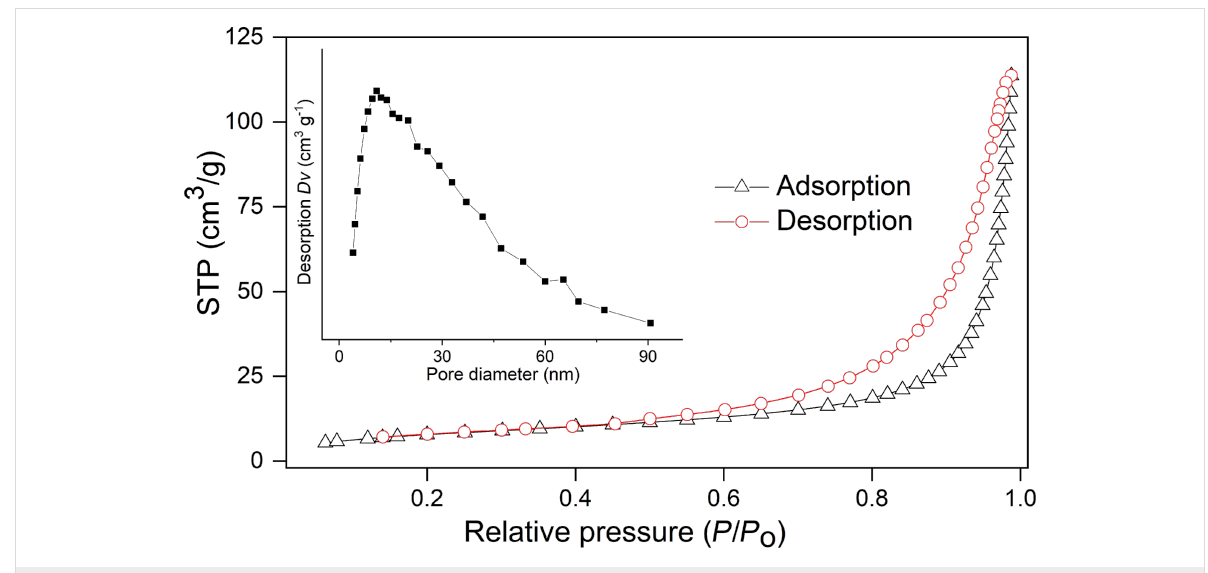
Figure 3: Nitrogen adsorption and desorption isotherms for ZnAl-NAA-LDH.